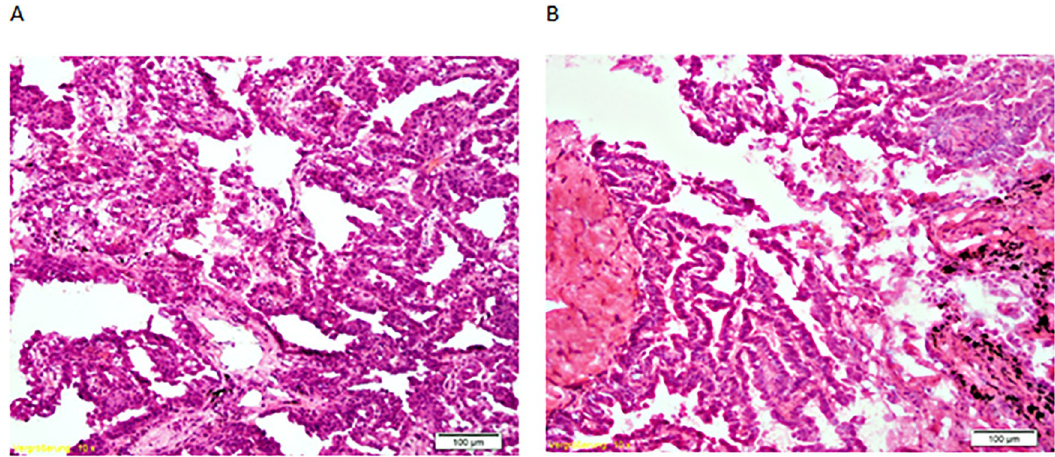
Fig 2. Histological evaluation. HE stained histological section of adenocarcinoma, patient 2. A: tissue preserved in RNAlater for 1 day; B: tissue snap frozen in liquid N 2 .